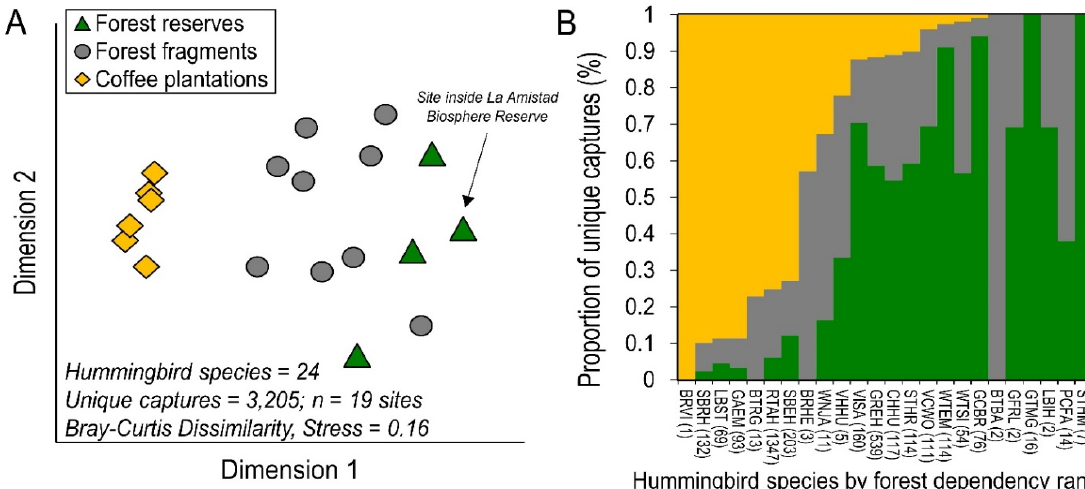
Figure 2. Analysis of community composition suggested that hummingbirds colonizing co ff ee plantations formed a novel biological community in the agricultural ecosystem. A multidimensional scaling plot of hummingbird abundance-based biodiversity coe ffi cients (Bray–Curtis Dissimilarity) illustrate di ff erences and similarities among sites, where sites located closer together on the plot were more similar in hummingbird biodiversity and farther distances between sites indicate dissimilarity. Note how forest sites are more spread out in space, indicating that they host more diversity across sites from a larger pool of species ( A ). A plot of e ff ort-adjusted proportions of unique captures of each hummingbird species suggests substantial overlap between communities in co ff ee plantations and in forest sites, with 17 of 24 species observed in both habitat types. Six species were so forest dependent that they were never observed in co ff ee plantations, and 4 of those species were rare ( < 10 total unique captures). Hummingbirds are labeled by species codes (see Table S1) and numbers below species codes indicate the total number of unique captures from 19 sites. Forest dependency rank is based on the e ff ort-adjusted proportion of unique captures in forest fragments and reserves ( B